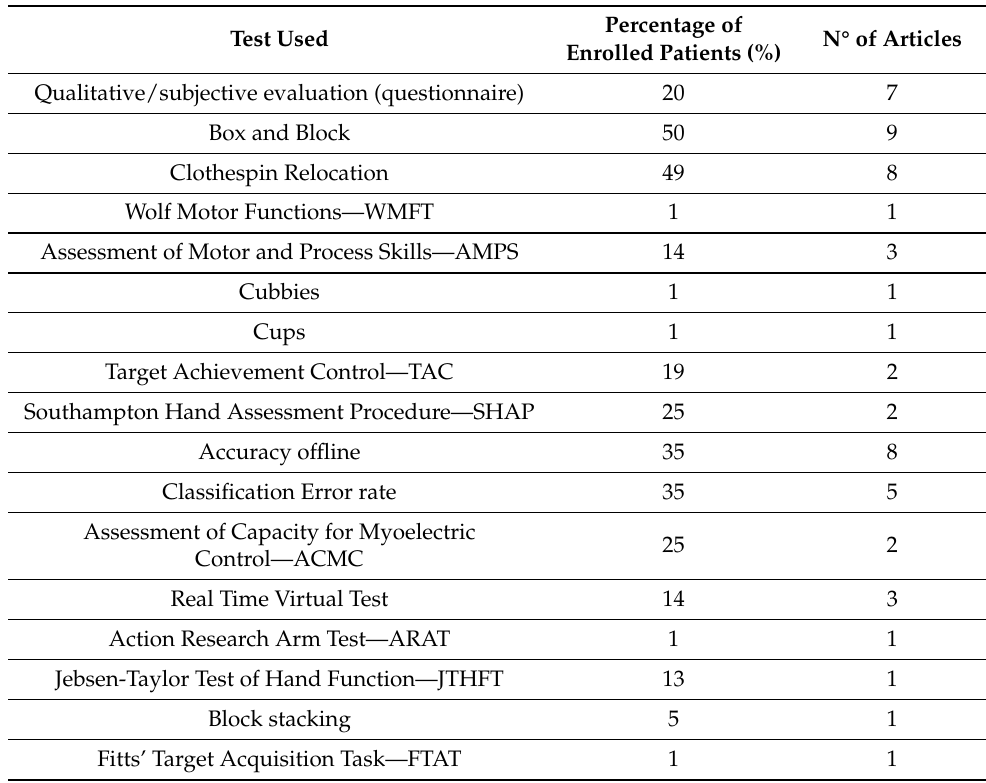
Table 2. Performance evaluation